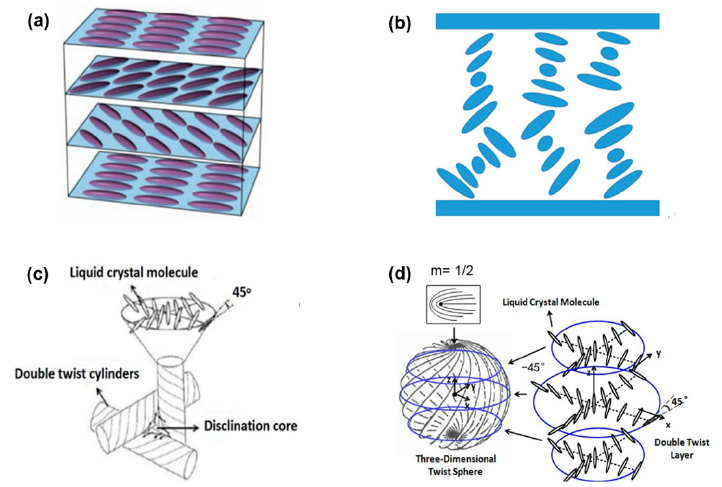
Figure 1. The arrangements of LC molecules in ( a ) planar texture state CLC; ( b ) focal conic state CLC; ( c ) BPLC; ( d ) SPLC.